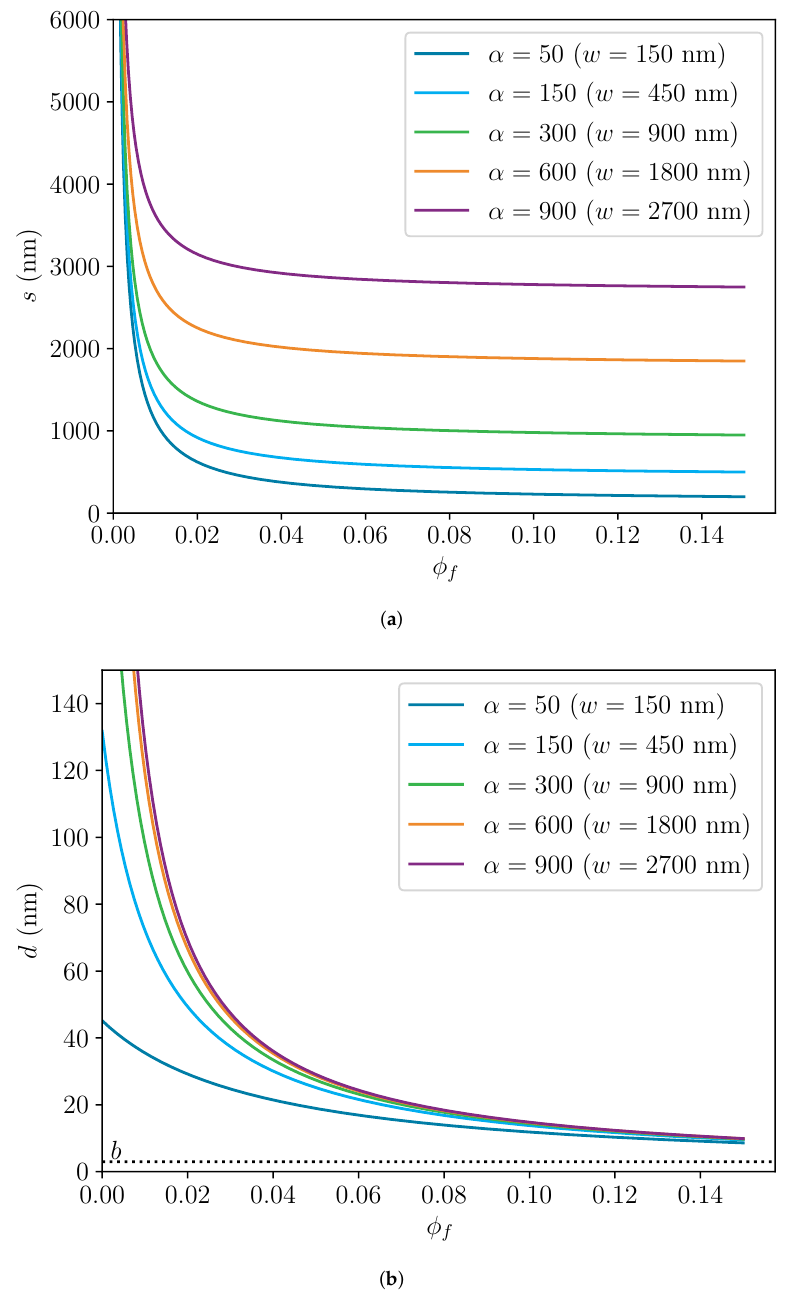
Figure 6. Calculations of slit distance s and filler distance. The thickness of the fillers b was always 3nm (dotted line). ( a ) Slit distance s , which was calculated with the channel model over the filler volume fraction φ f . ( b ) Filler distance d , which was calculated with the channel model over the filler volume fraction φ f